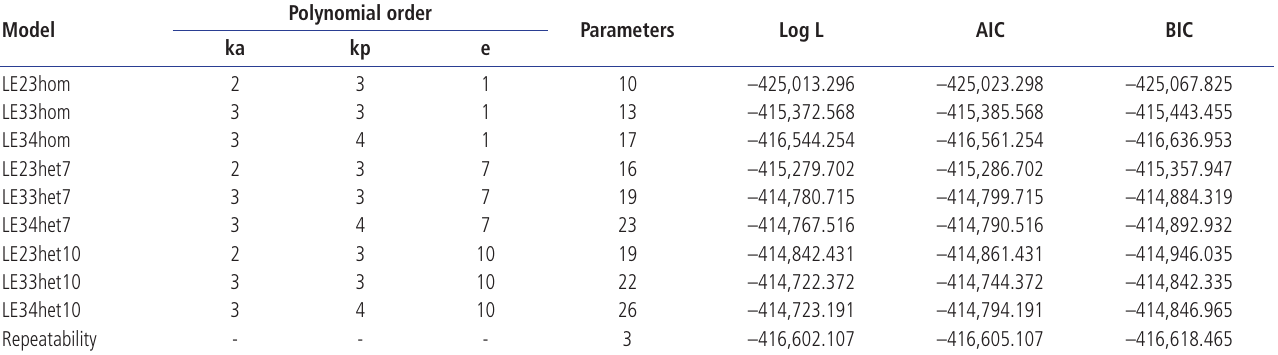
Table 2. Orders of polynomials for additive genetics (Ka), permanent environment (Kp), residual variances structures (hom or het), Log L, AIC, and BIC for different random regression model Model